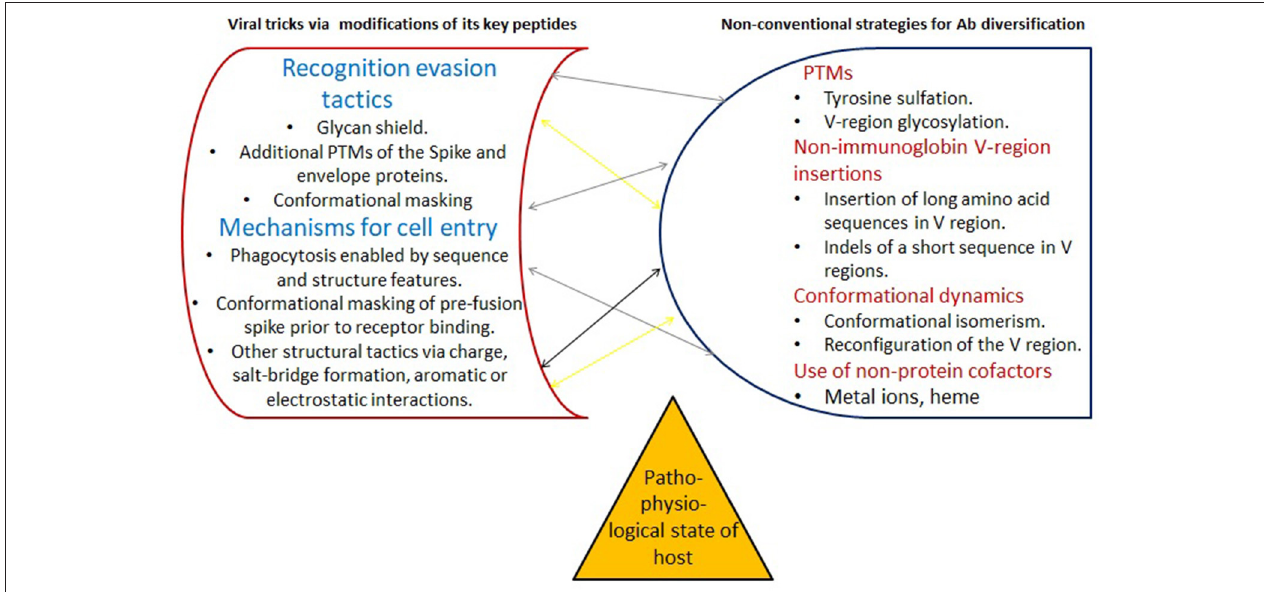
FIGURE 4 | Non-genetic modification strategies on both sides. Right: Adaptive immunity relies on sophisticated genetic mechanisms to create the diversity of antibody V regions. Several rarely recognized routes for diversification of antibody specificities (left) add an increased level of adaptability and plasticity, far beyond that encoded in the genome or generated by acquisition of somatic mutations [reviewed in Kanyavuz et al. (2019)]. They may be necessary to combat the various tricks viruses are using which are also far beyond what is encoded in their linear amino acid sequence (right). Both, the immune system and the virus, likely evoke various strategies simultaneously. Depending on their context (e.g., the pathophysiological context of the host, interrelationship with the other arms of the immune system - not depicted), some of the beyond sequence determined diversification mechanisms may not be available or adequately expressed. Left: PTMs also apply to viral proteins. They add temporal and spatial regulation to modulate their functions, in particular to enhance viral immune evasion tactics. PMS, post-translational modifications - the covalent modifications of polypeptides after they are synthesized. Ab,